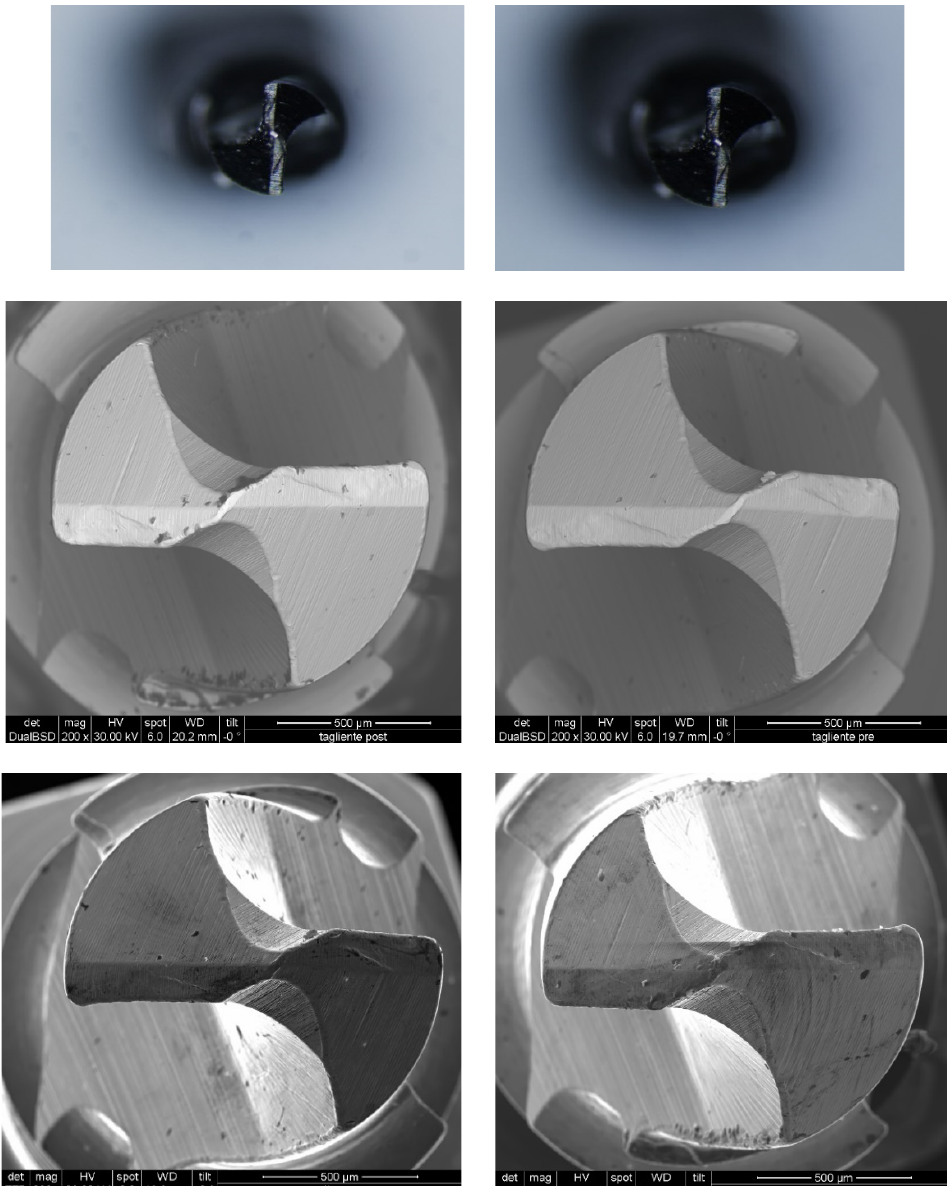
Figure 3. Images of miniscrews by stereomicroscope and SEM before and after insertion in the artificial bone block composed of a cortical bone layer with a density of 0.64 g / cm 3 (40 PCF). The authors performed a qualitative evaluation by examining only the behavior of the miniscrew in the bone block with greater density (0.64 g / cm 3 , 40 PCF). This is the most stressful test for miniscrews. If the screw does not undergo deformation during this test, it will not undergo any deformation in the lower-density blocks. Mean values for maximum insertion torque (MIT) showed di ff erent MITs for the di ff erent insertion blocks. With all the screws, the MIT increased with increasing cortical bone thickness (Figure